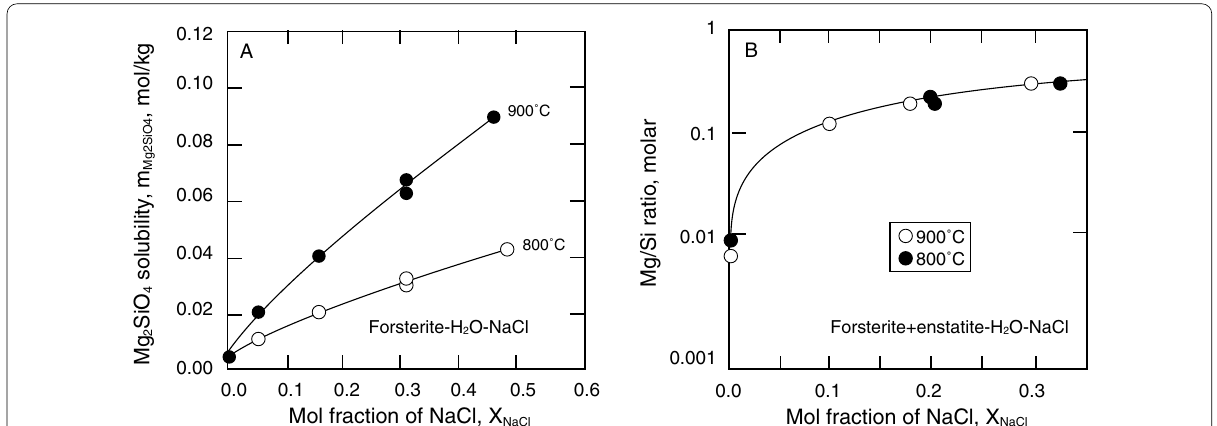
Fig. 17 A. Mg 2 SiO 4 solubility in H 2 O–NaCl fluid as a function of mol fraction of NaCl at 1 GPa and at temperatures indicated. B. Mg/Si ratio of H 2 O– NaCl fluid in equilibrium with forsterite enstatite at 1 GPa and 800° and 900 °C as a function of NaCl concentration of the fluid. Modified from + Macris et al. (2020)